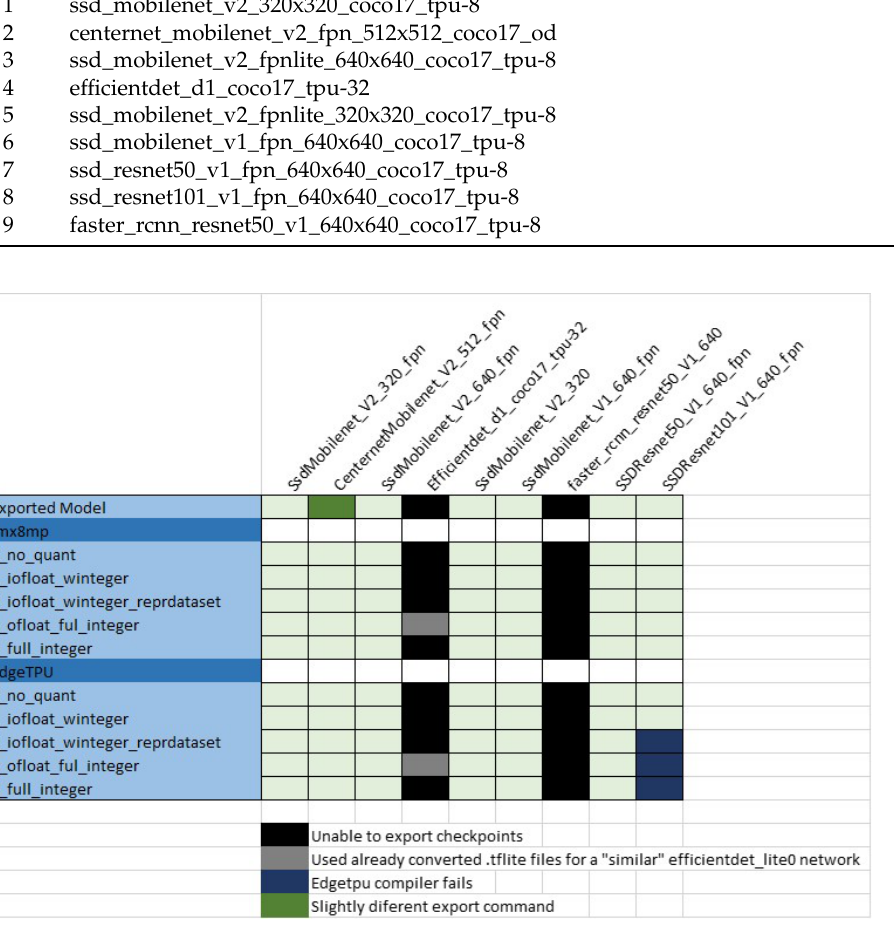
Figure 6. TensorFlow Lite model conversion